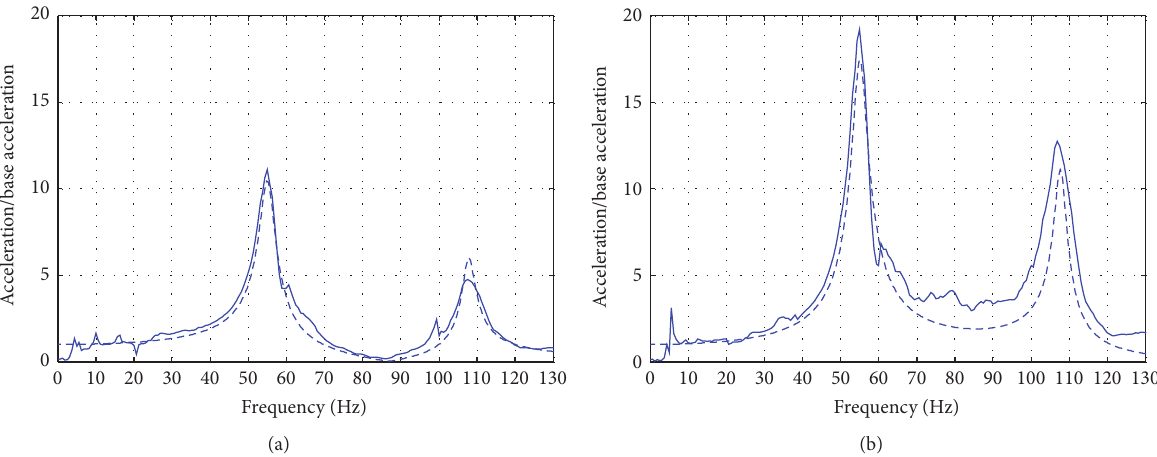
Figure 17: The measured acceleration transmissibility measured from the experiment for the case of no friction and thin secondary beam. (a) The primary system response. Solid line: acceleration at the end of the first beam (sensor 2). Dashed line: predicted acceleration of the primary mass using fitted parameters. (b) The secondary system response. Solid line: acceleration at the end of the secondary beam (sensor 3). Dashed line: predicted acceleration of the secondary mass using fitted parameters.